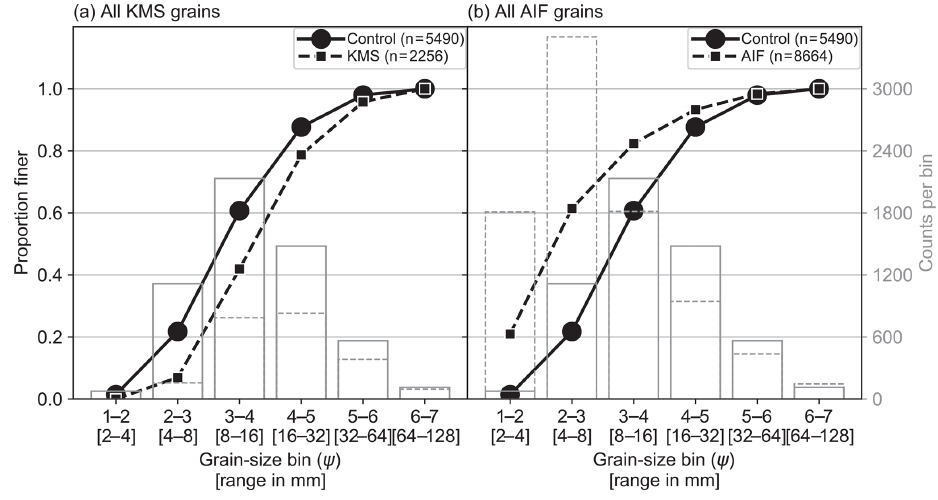
Figure 8. Comparison of (a) KMS and (b) AIF at the 12 field sites all aggregated and coarsely binned. Control is shown as solid black (left y axis) and gray (right y axis) lines and KMS and AIF as the dashed lines.